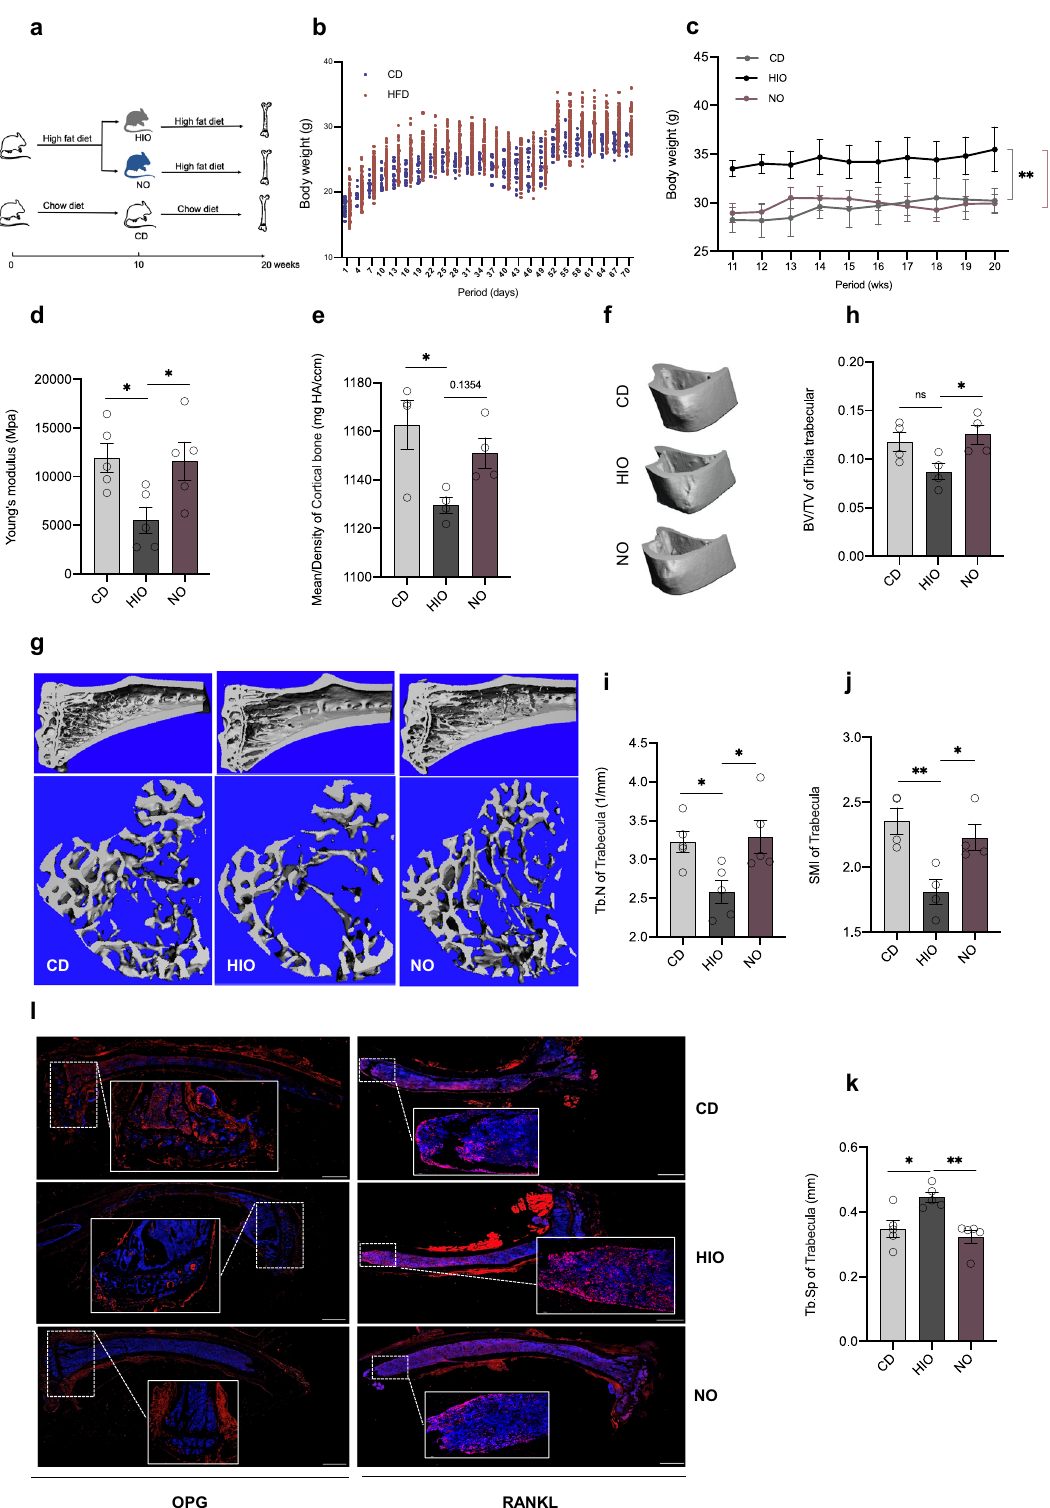
Fig. 1 HIO, but not HFD, induced bone loss in mice. a Study design. Tibia were harvest after 20 weeks HFD intervene for HIO and NO mice on bone property analysis. b Body weight changes after chow diet ( n = 14) and HFD ( n = 81) fed during 70 days. c Body weight of HIO, NO, and CD mice ( n = 7) after 10 weeks of HFD or chow diet, respectively. d Young ’ s modulus ( n = 5). Tibia was analyzed by μ -CT ( n = 4 – 6) to access ( e ) the mean/density of cortical bone, ( f ) generate representative cortical bone images, ( g ) three-dimensional reconstruction images of cancellous bone, ( h ) BV/TV of tibia trabecular, ( i ) trabecular number (Tb. N), ( j ) SIM of Trabecula and ( k ) trabecular separation/spacing (Tb. Sp). l Immunohistochemistry of OPG and RANKL expression (12×), length of the scale bar is 1000 μ m. Data are presented as means ± standard errors of the means (± SEM). Results determined by one-way ANOVA. * p < 0.05, ** p < 0.01, *** p <